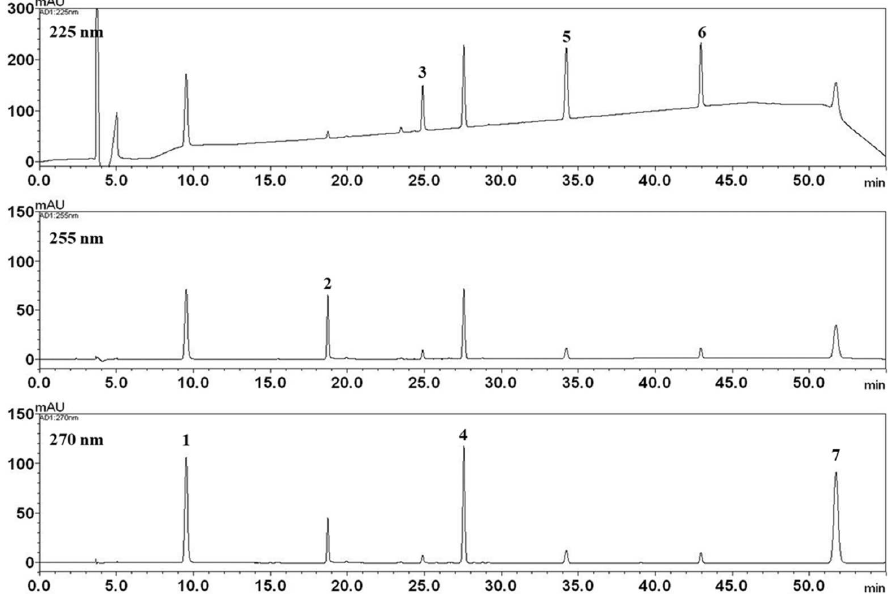
Figure 3. HPLC chromatogram of MRC analyzed by HPLC-PDA. Gallic acid (1), oxypaeoniflorin (2), paeoniflorin (3), ethyl gallate (4), benzoic acid (5), benzoylpaeoniflorin (6), paeonol (7).